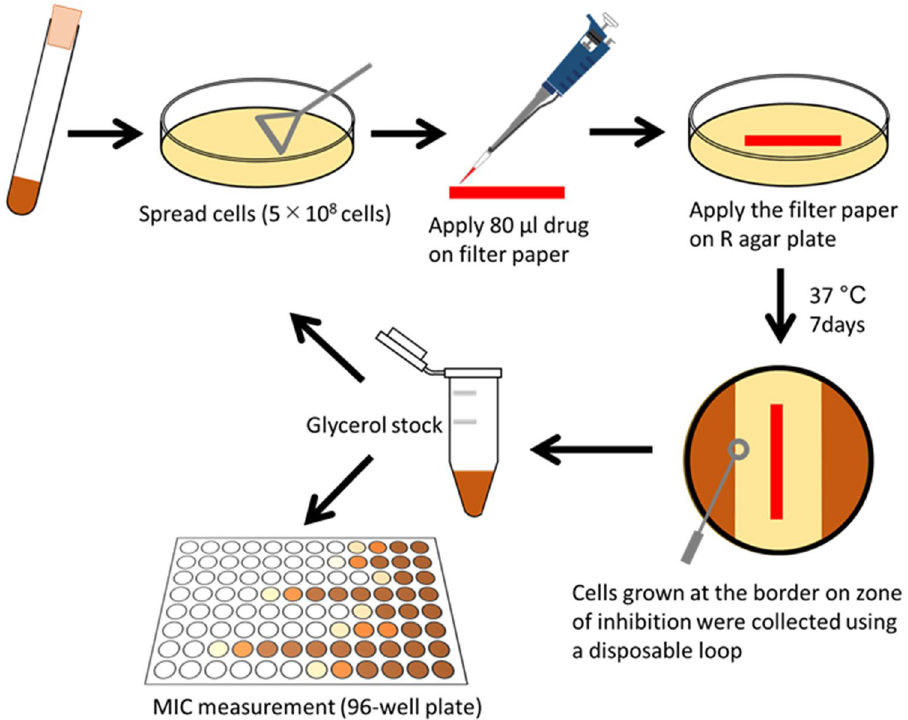
Figure 1. Schematic overview of laboratory evolution. In this experiment, 5 × 10 8 cells were spread on an R agar plate, and a filter paper soaked with the corresponding drug solution was placed on the surface of the culture. The plate was incubated for 7 days at 37 °C. After incubation, the colonies at the border of the zone of inhibition were collected on an inoculation loop, and 5 × 10 8 cells were deposited on a fresh R agar plate, and a drug-soaked filter paper was placed following the same method as that followed on the first day of the experiments. The cells transferred at each passage were stocked in glycerol at − 80 °C for minimum inhibitory concentrations (MIC)